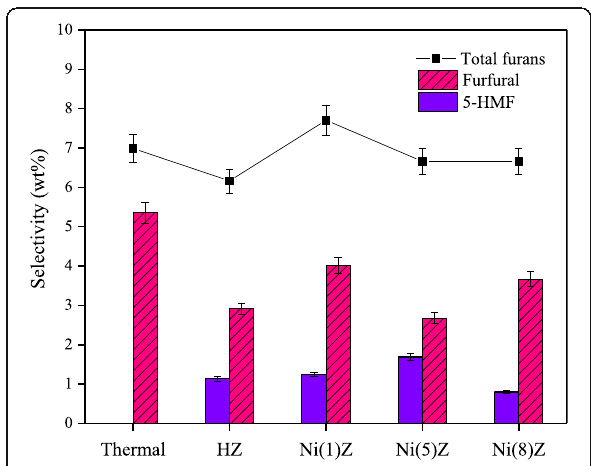
Fig. 4 Selectivity towards furans, furfural and 5-HMF in biooils from PS pyrolysis catalyzed by